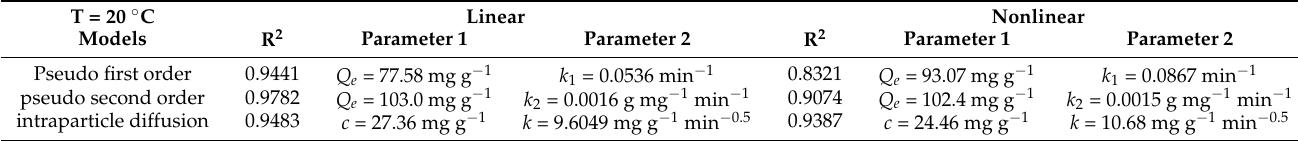
Table 3. Summary of kinetics parameters of GST adsorption on